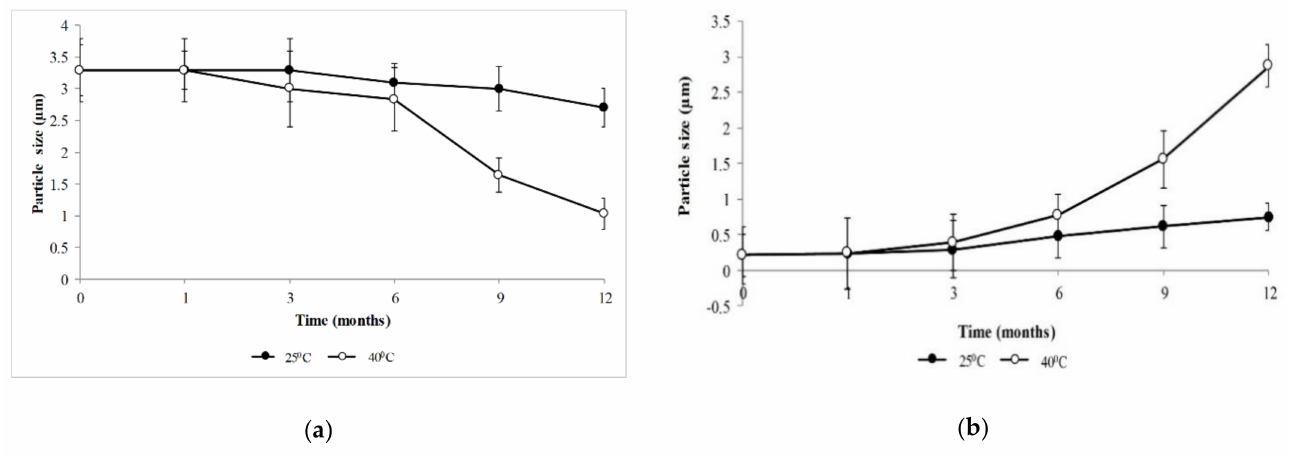
Figure 1. Particle sizes of the formulations. ( a ) The microencapsulated formulation; ( b ) the non-encapsulated formulation. Stored at 25 ± 2 ◦ C/60% ± 5% RH and 40 ± 2 ◦ C/75% ± 5% RH. The results are represented by mean ± SD.